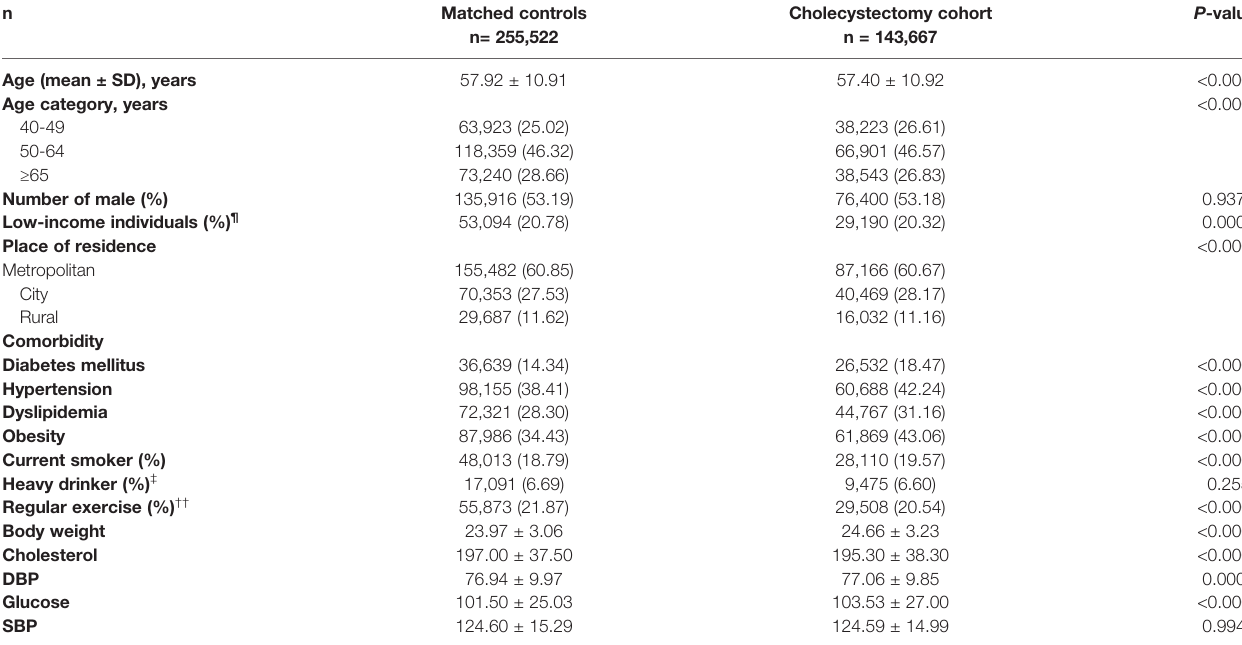
TABLE 1 | Demographics of the study